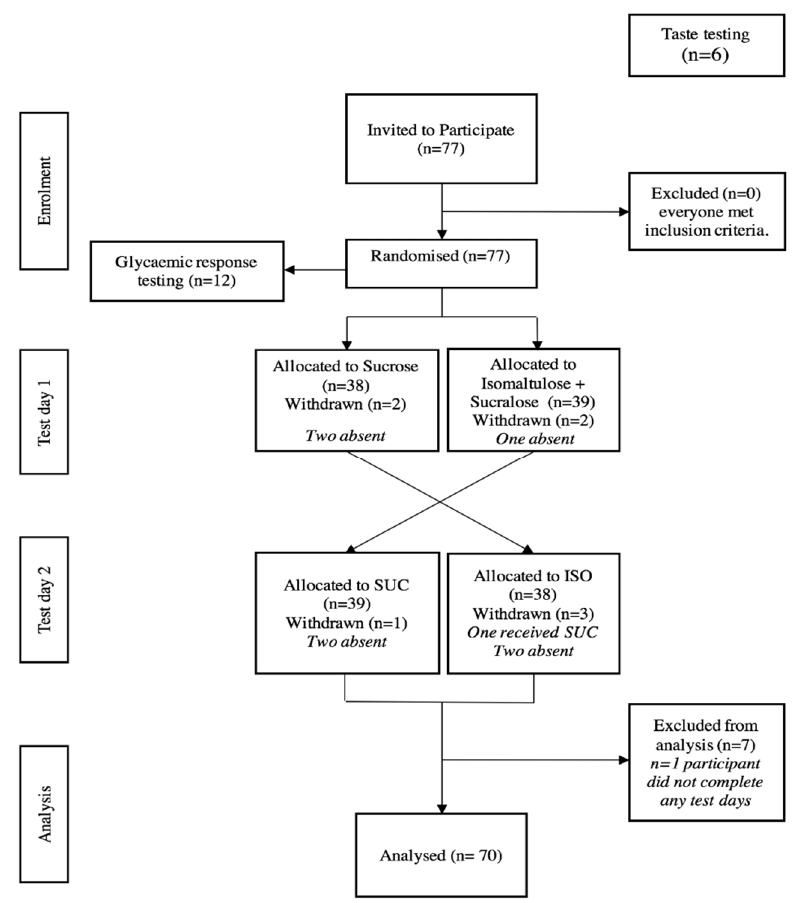
= sucrose; ISO = isomaltulose and